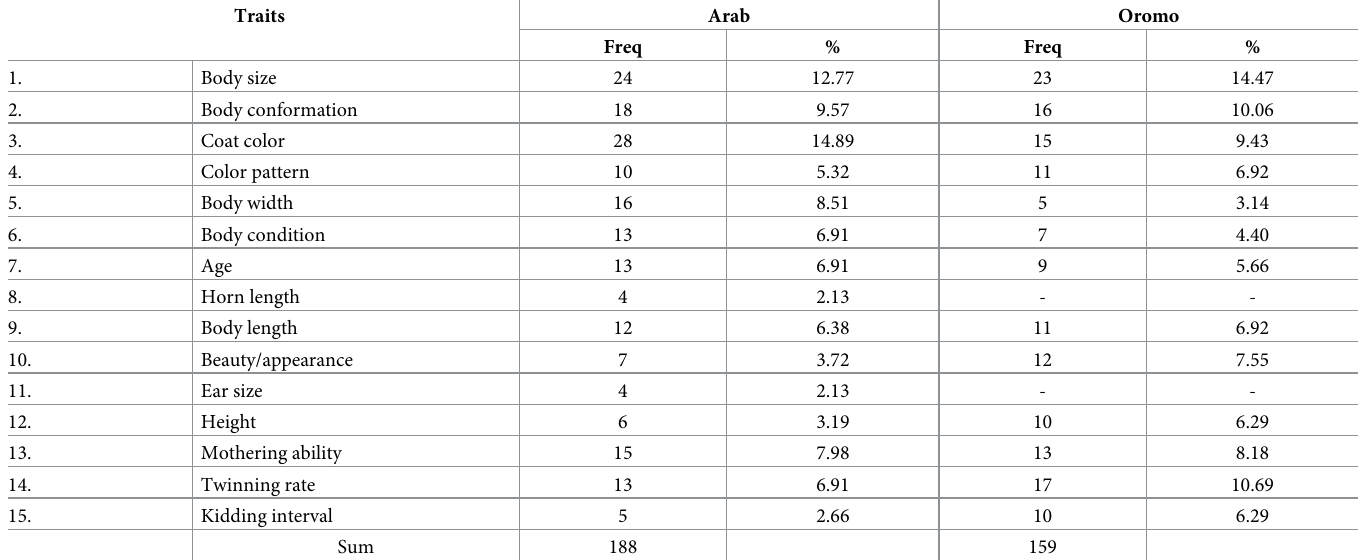
Table 3. List of doe traits in group-animal ranking experiments.